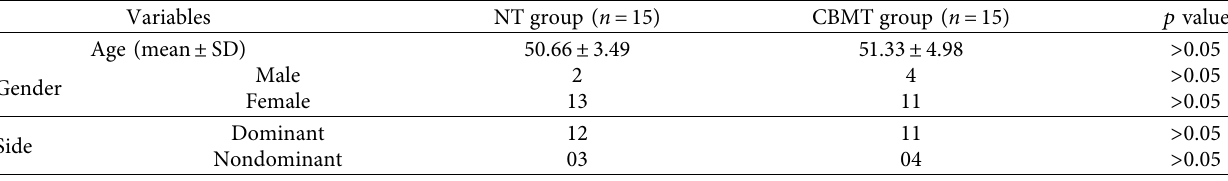
Table 1: Participants demographics distribution between the groups ( n � 15/group) using Shapiro–Wilk test (95% CI). Variables